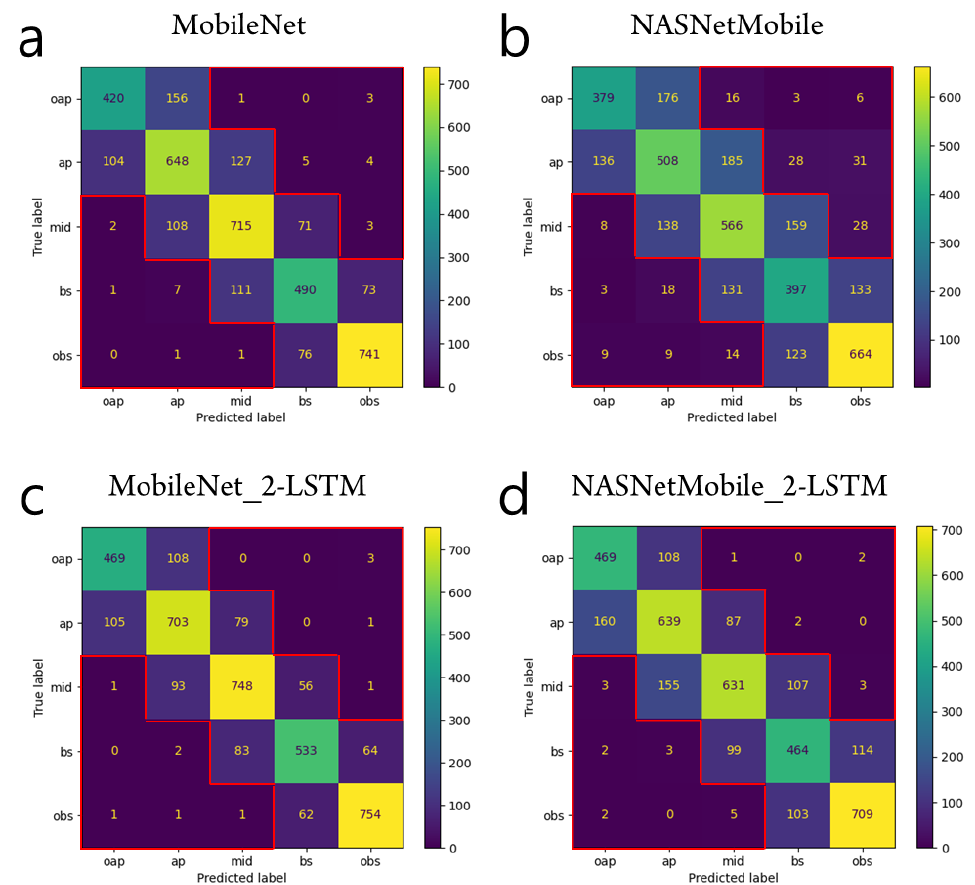
Figure 4. Test prediction results from the CNN-alone models ( a , b ) and from the CNN-RNN models ( c , d ). In either MobileNet or NASNetMobile, the CNN-RNN model has smaller sums of the elements out of the tridiagonal entries (SOTD) than the CNN-alone model. The elements out of the tridiagonal entries are indicated by the red contours in the confusion matrices. For example, SOTD is 11 for the case of MobileNet_2-LSTM in ( c ).